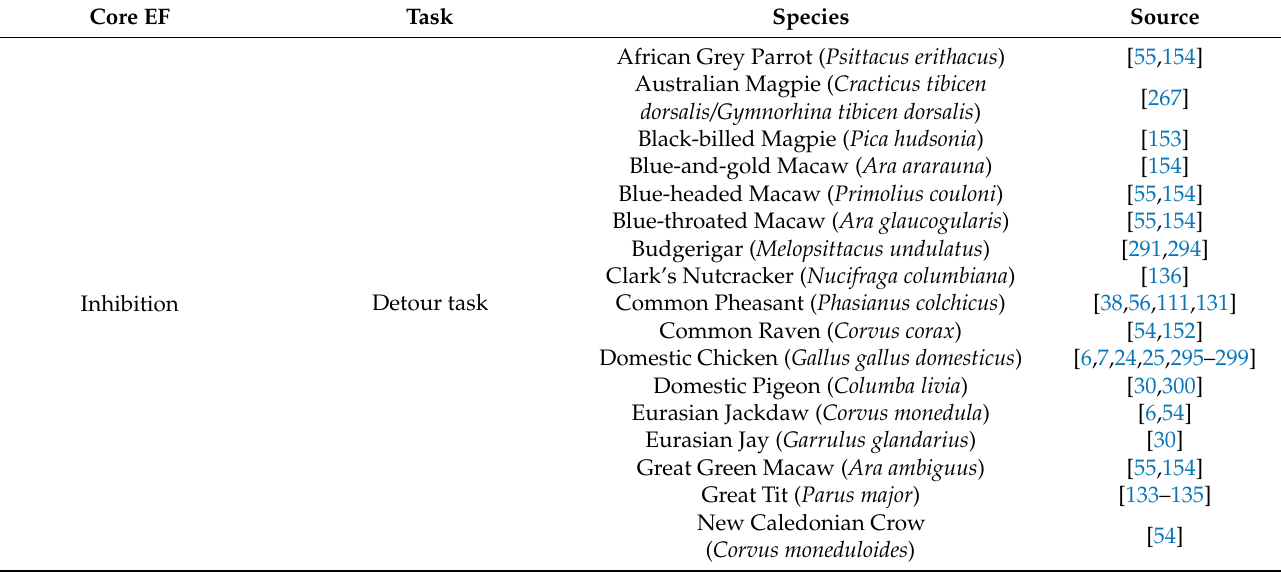
Table 2. Overview of EF tasks tested with bird species.